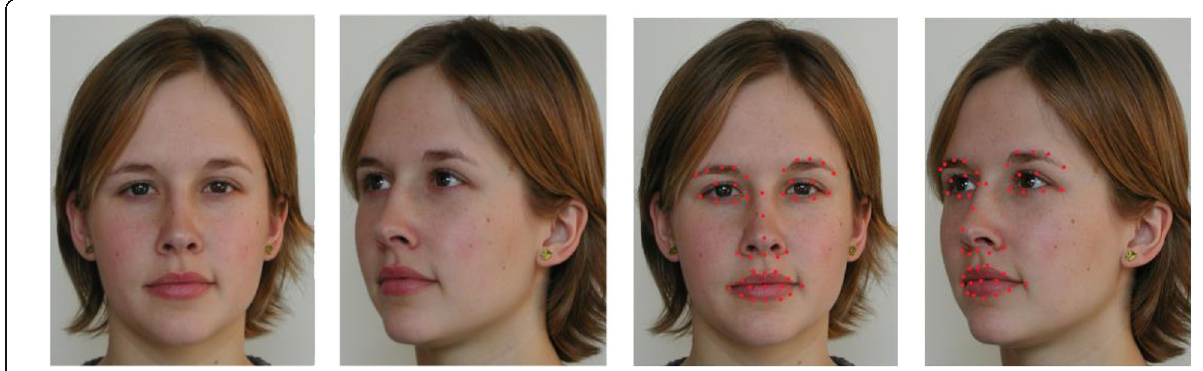
Fig. 2 Schematic diagram of important characteristics detection. a Frontal face to be identified. b − 45°face to be identified. c Frontal face key feature points. d − 45 °key feature